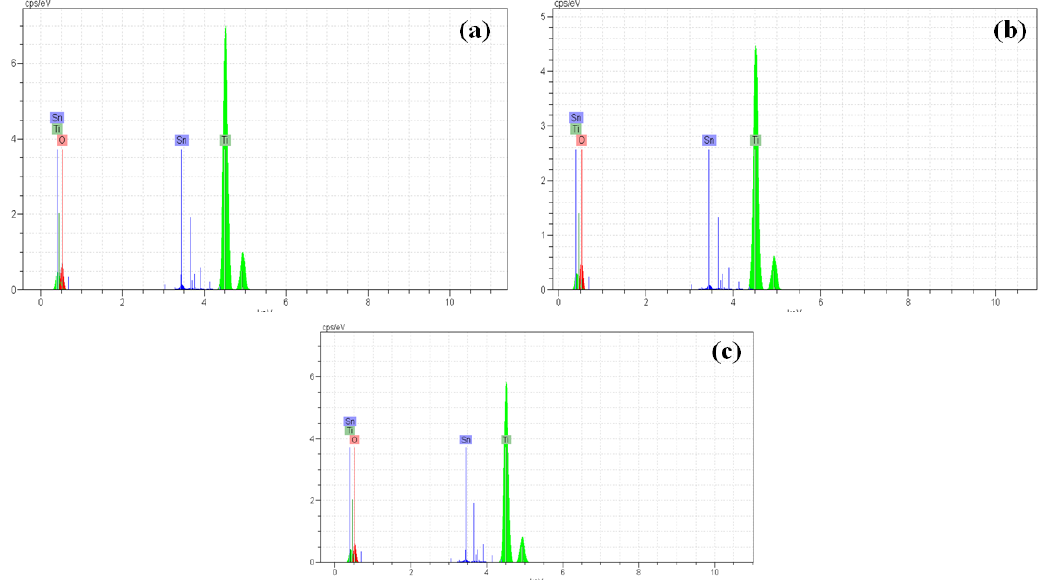
Table 1. EDX analysis of pure and various Sn-doped TiO